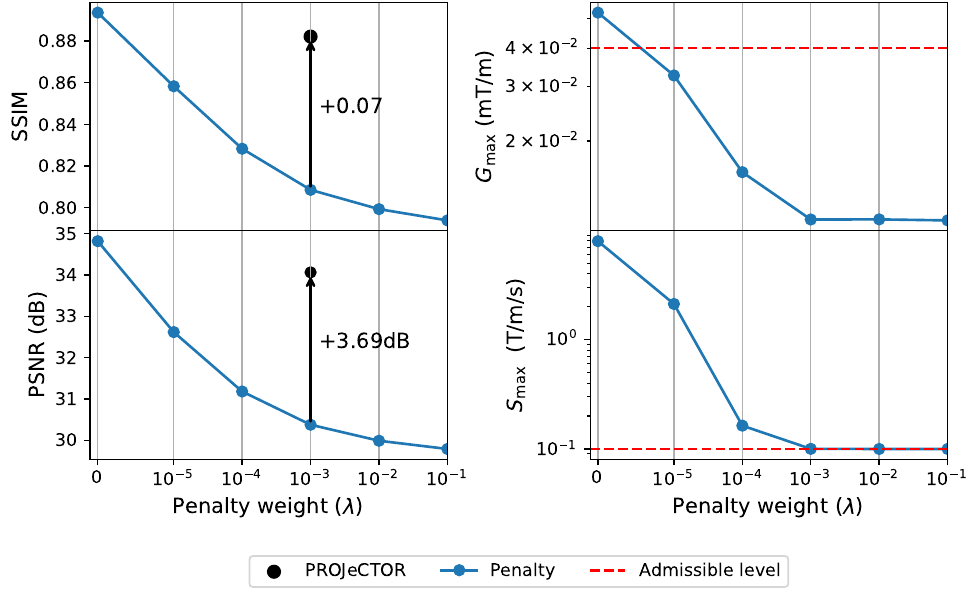
Figure 6. ( Left ): Performance metrics in SSIM and PSNR of penalty-based methods at varying penalty weight λ . The performance PROJeCTOR is also shown for comparison. ( Right ): The feasibility of the penalty-based learned k -space trajectories at varying penalty weights (i.e., hyper-parameter) λ , shown by maximum slew rate S max and maximum gradient strength G max in the entire sampling pattern. The respective admissible upper levels are drawn with a red-dotted